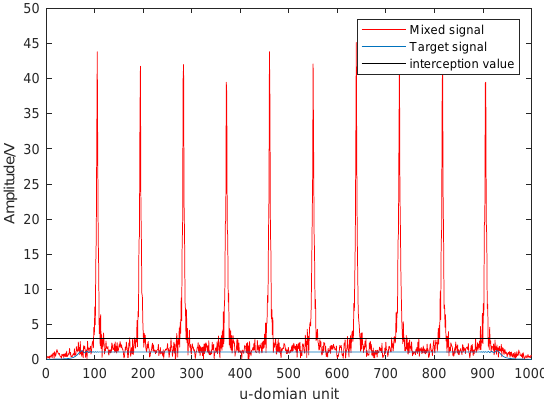
Figure 10. u -domain waveform of mixed signal.